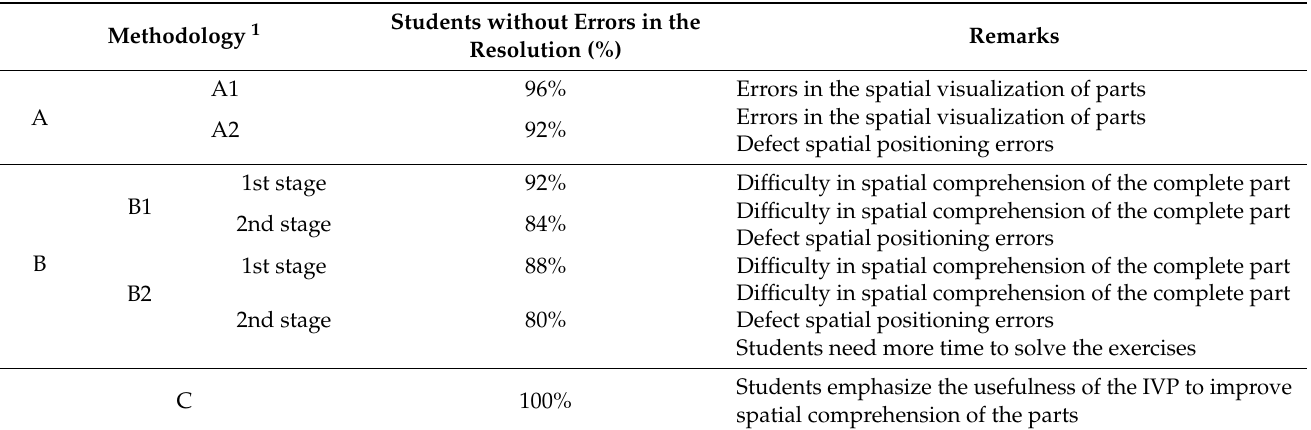
Table 1. Obtained results applying the proposed